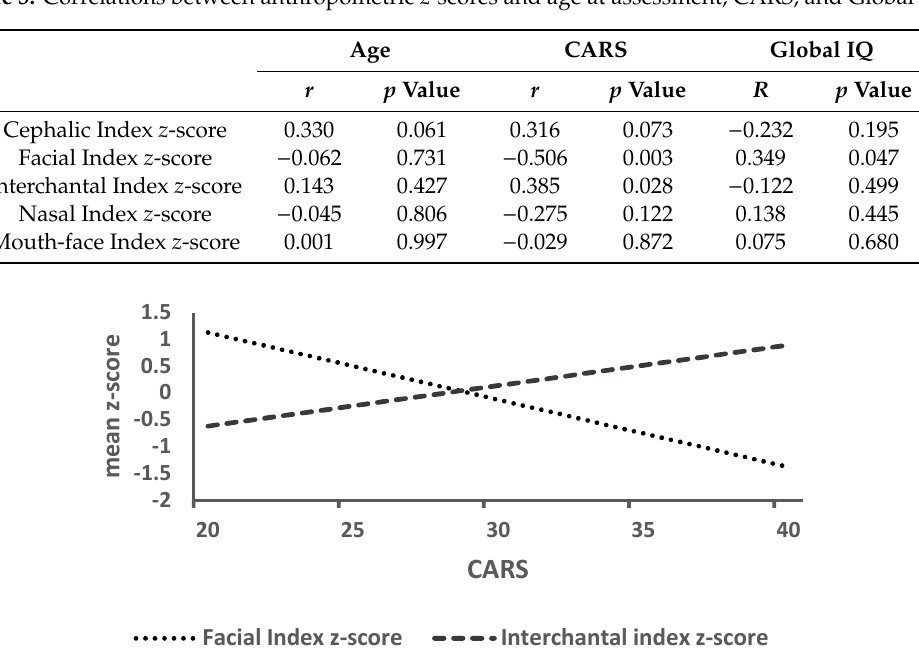
Figure 2. Anthropometric z -scores in the sample of 33 ASD patients (CI: Cephalic index, FI: Facial